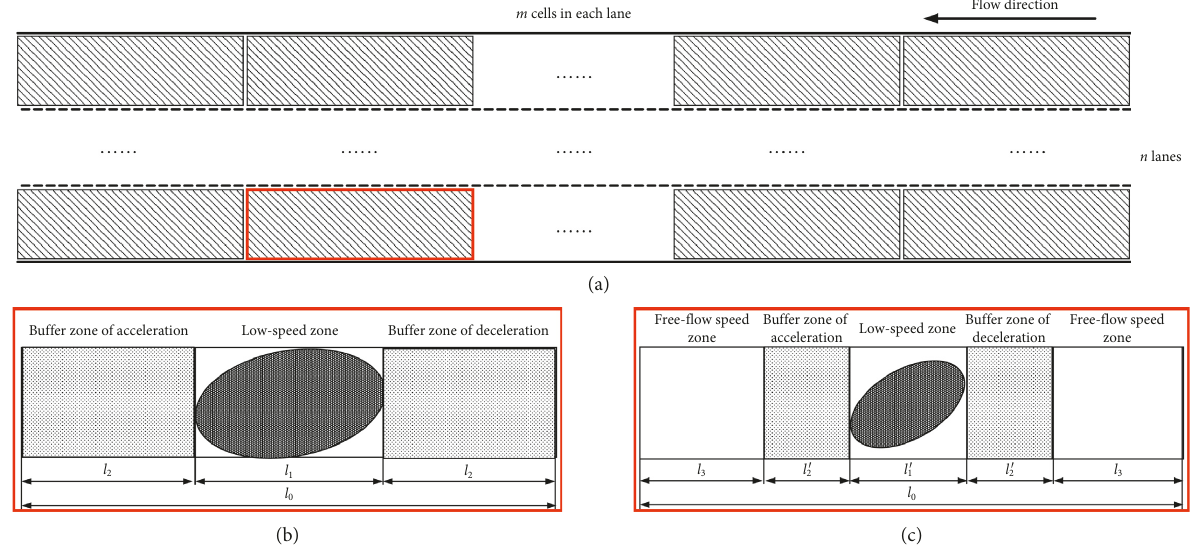
Figure 1: Lane-cell division on the research segment and the constituents of the PD cell. (a) Lane-cell division on the investigated segment. (b) The heaviest PD cell. (c) The general PD